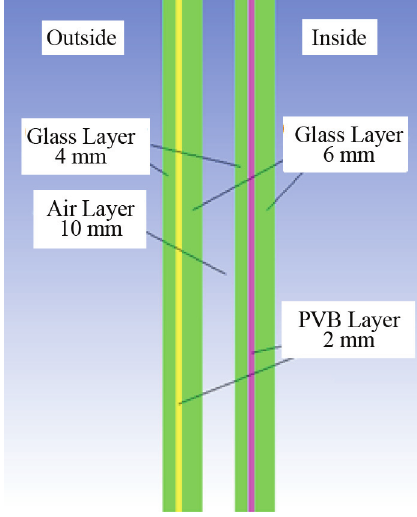
Fig. 2. A section of laminated glass